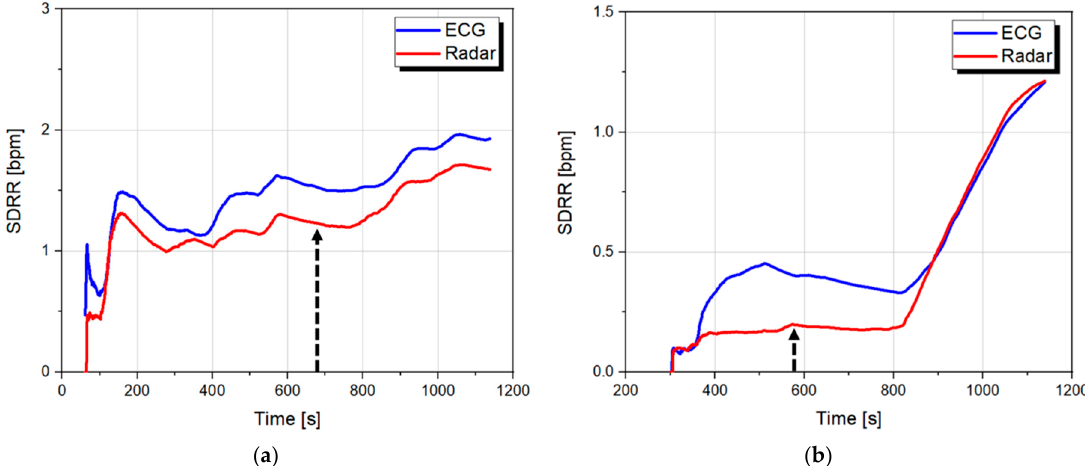
Figure 10. Variation of the SDRR for subject 5 in wake–drowsiness states: ( a ) Using the window size of 60 s; ( b ) using the window size of 300 s.